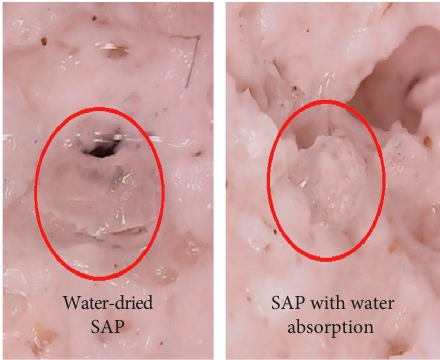
Figure 15: SAP absorbed inside the specimen.